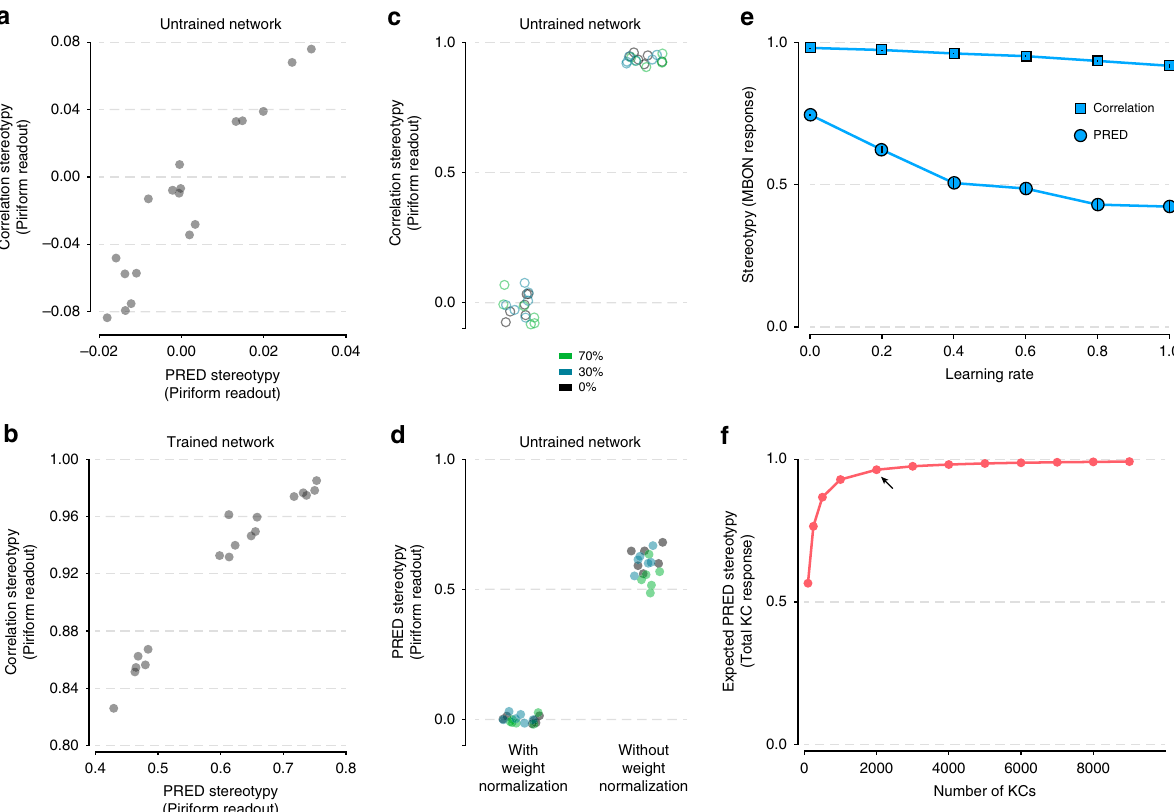
Fig. 3 Stereotypy does not require learning. a , b Comparison of PRED stereotypy with correlation stereotypy in the responses of the readout neuron in the simulations of the untrained ( a ) or trained ( b ) piriform network using code provided by Schaffer et al. 24 . c , d Stereotypy in the simulations of the untrained piriform network, with and without the weight normalization step calculated using both correlation ( c ) and PRED ( d ) metrics. The three different colors represent simulations with different levels of overlap among the olfactory bulb responses to odors as described by Schaffer et al.: 70% overlap (green), 30% overlap (blue) and 0% overlap (gray). a – d have 18 data points each (6 iterations × 3 sets of odors). e Stereotypy in MBON response reduces with the learning rate, as seen in simulations with 100 odors and 2 individuals. Learning of an odor resulted in either increasing or decreasing the number of synapses between the MBON and the KCs activated by that odor. Half of the odors, selected randomly for each individual, were learnt sequentially, and each learning event resulted in increase or decrease in synapses with equal probability. When the synapses were increased, of all the KCs that were activated by the learned odor and were not connected to the MBON, a certain fraction (indicated by the learning rate) were connected to the MBON. When the synapses were reduced, of all the KCs that were activated by the learned odor and were connected to the MBON, the same fraction were disconnected from the MBON. The MBON responses for both individuals were recalculated after modifying the synapses, n = 100 iterations. Error bars represent s.e.m. f Analytical model proved the existence of stereotypy in absence of learning. Plot of stereotypy versus the number of KCs suggested a dependence of stereotypy on the size of the network, as later seen in the simulations (compare to Fig. 6d). Each value is calculated using the formulae derived in the analytical model (see Supplementary equations). Arrow indicates the default value (matching the Drosophila